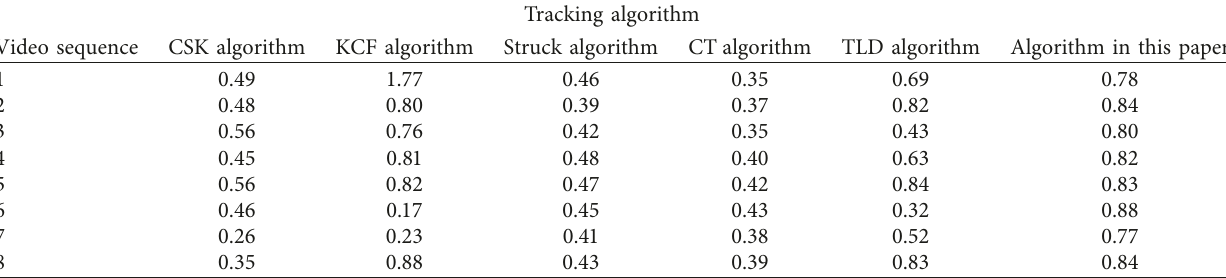
Table 1: Accuracy of different algorithms and comparison results.